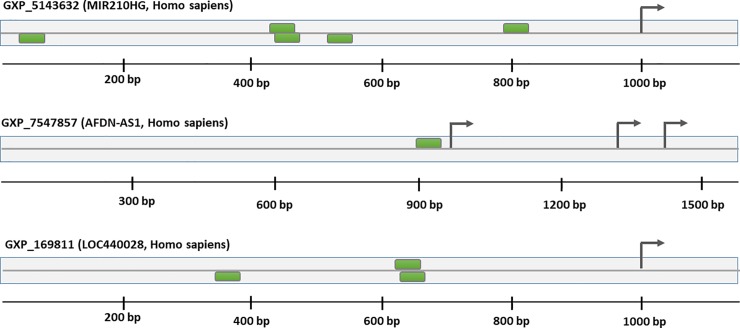
Presence of hypoxia response elements (HREs) in the predicted promoters of long non-coding RNAs (lncRNAs).All three lncRNAs harbored the hypoxia response elements (HRE) within their promoters that identified by the Genomatix MatInspector database. Genomatix optimized length for the promoters is nearly 1,000 bp upstream of the first TSS and 100 bp downstream of the last TSS. Green boxes indicated HREs in the predicted promoter sequences on both orientations (“+” or upper strand or 5'—>3՛; “–” or lower strand or 3'—>5՛). Black arrows represented transcription start sites (TSS). Three TSS on the MLLT4-AS1 (AFDN-AS1) promoter indicated three alternative transcripts identified by Genomatix MatInspector database.